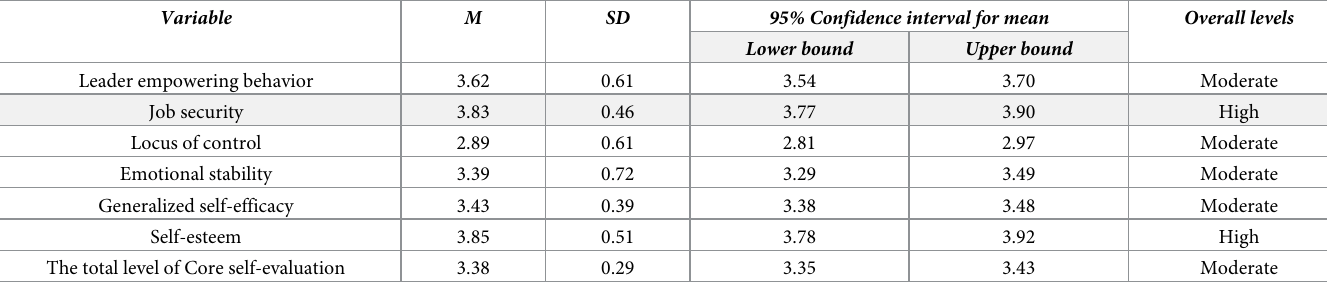
Table 2. Means, standard deviations, confidence interval, and overall levels of the study variables. Variable